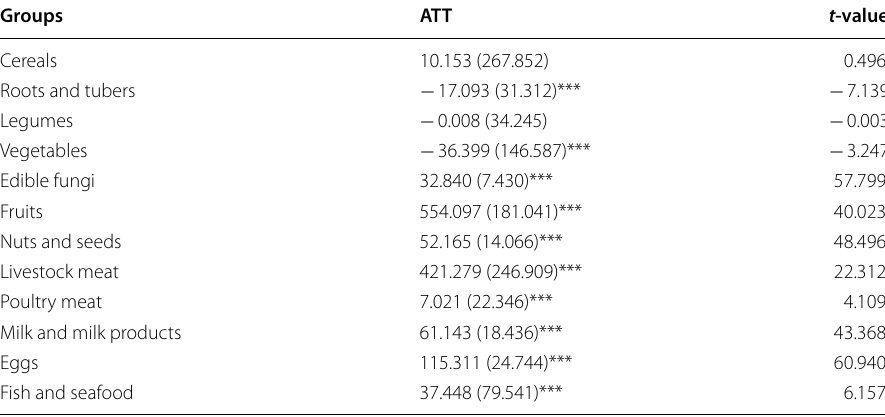
*** < 0.01. Robust standard errors are presented in